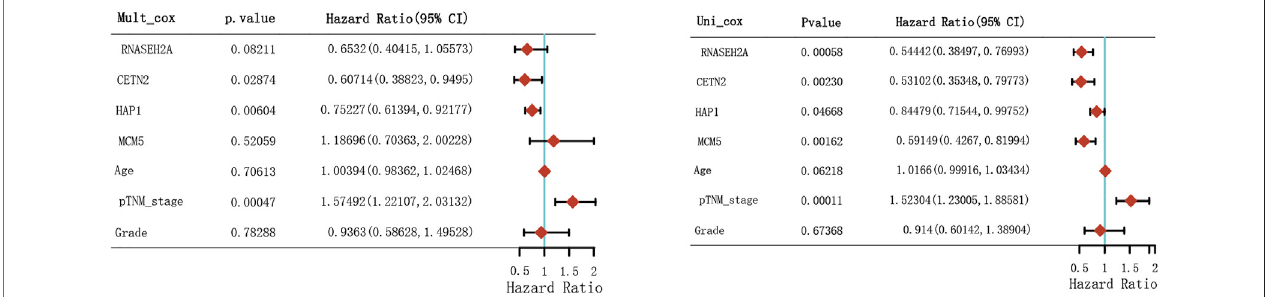
FIGURE 6 | Hazard ratio and p -value of constituents involved in univariate and multivariate Cox regression.